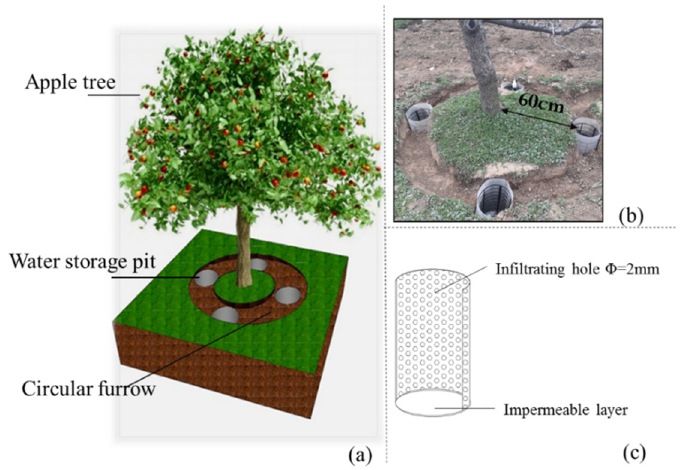
Figure 2. Diagram of water storage pit irrigation (WSPI) systems. ( a ) Field three-dimensional schematic. ( b ) Actual location of water storage pit arrangement, and the pit edge was 60 cm from the trunk. ( c ) Water storage pit.